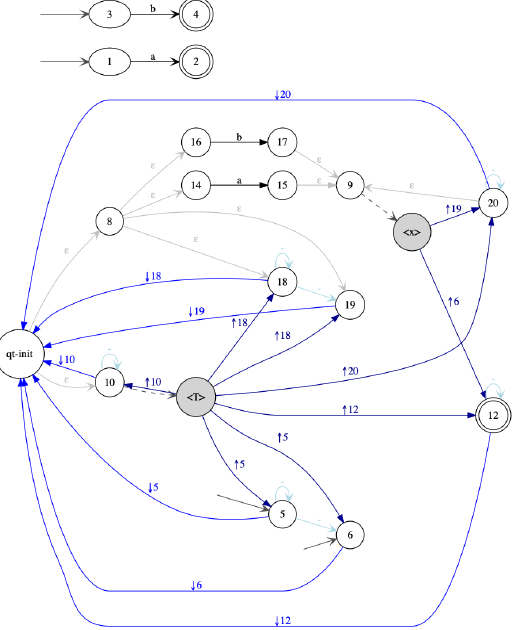
Figure 19. The single-entry NWA nwa ( step ( ch ∗ ( a + b ))) obtained from the SHA .